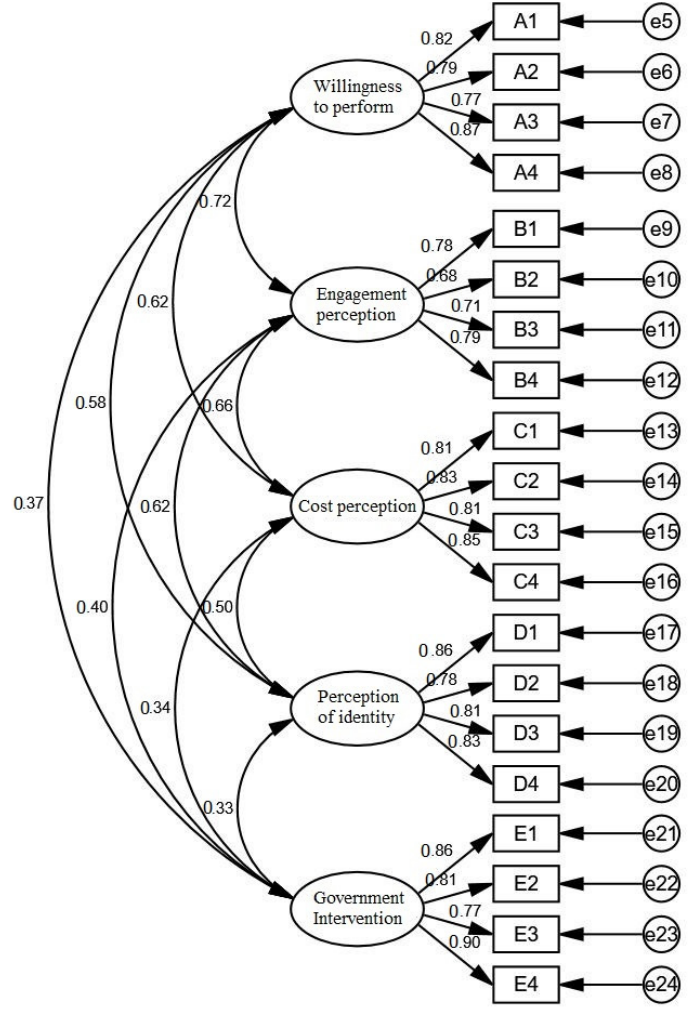
Figure 3. Validation factor model. Table 8. Model fitting metrics.